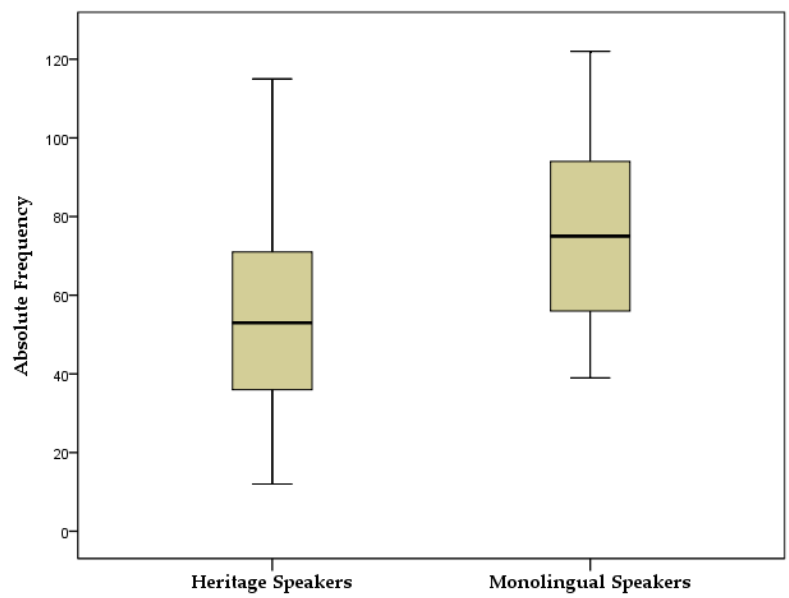
Figure 2. Boxplot: Lexical distribution and variation per group of EP speakers regarding the total corpus.